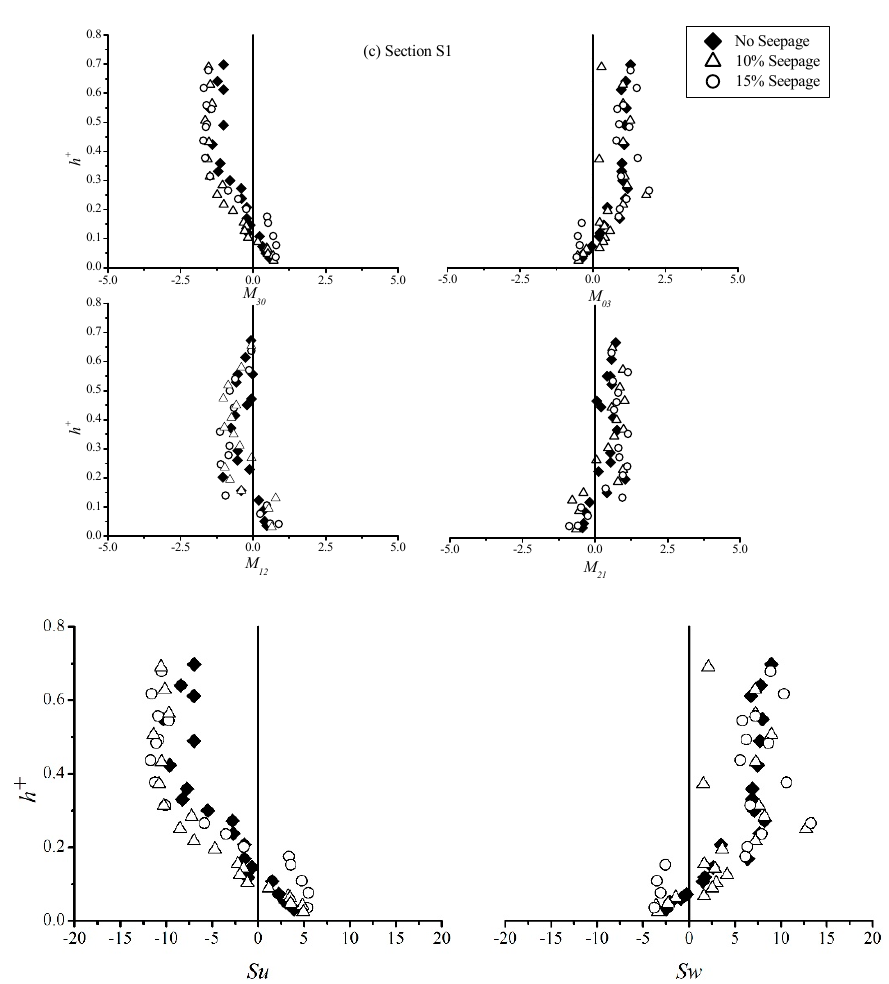
Figure 3. Non-dimensional distribution of third order moment and skewness factors in streamwise and vertical direction for without seepage (NS), 10% seepage (S), and 15% S runs in the following sections: ( a ) upstream the pier (U); ( b ) downward the pier (D); ( c ) laterally to the pier (S1).